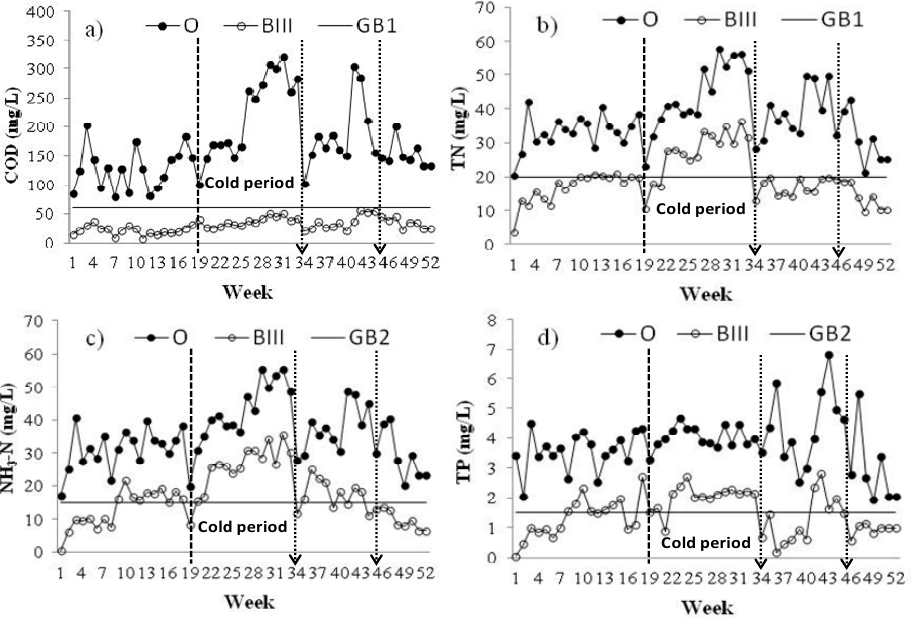
Figure 2. Change in pollutant concentration with operation time (O: influent; BIII: effluent; GB1: stricter first B discharge standard; GB2: old first B discharge standard; Interval between two dotted lines: cold period; Dotted arrow lines: point of sludge drainage. The relative deviations of the average values were within the range between 0.3% and 6.1%).